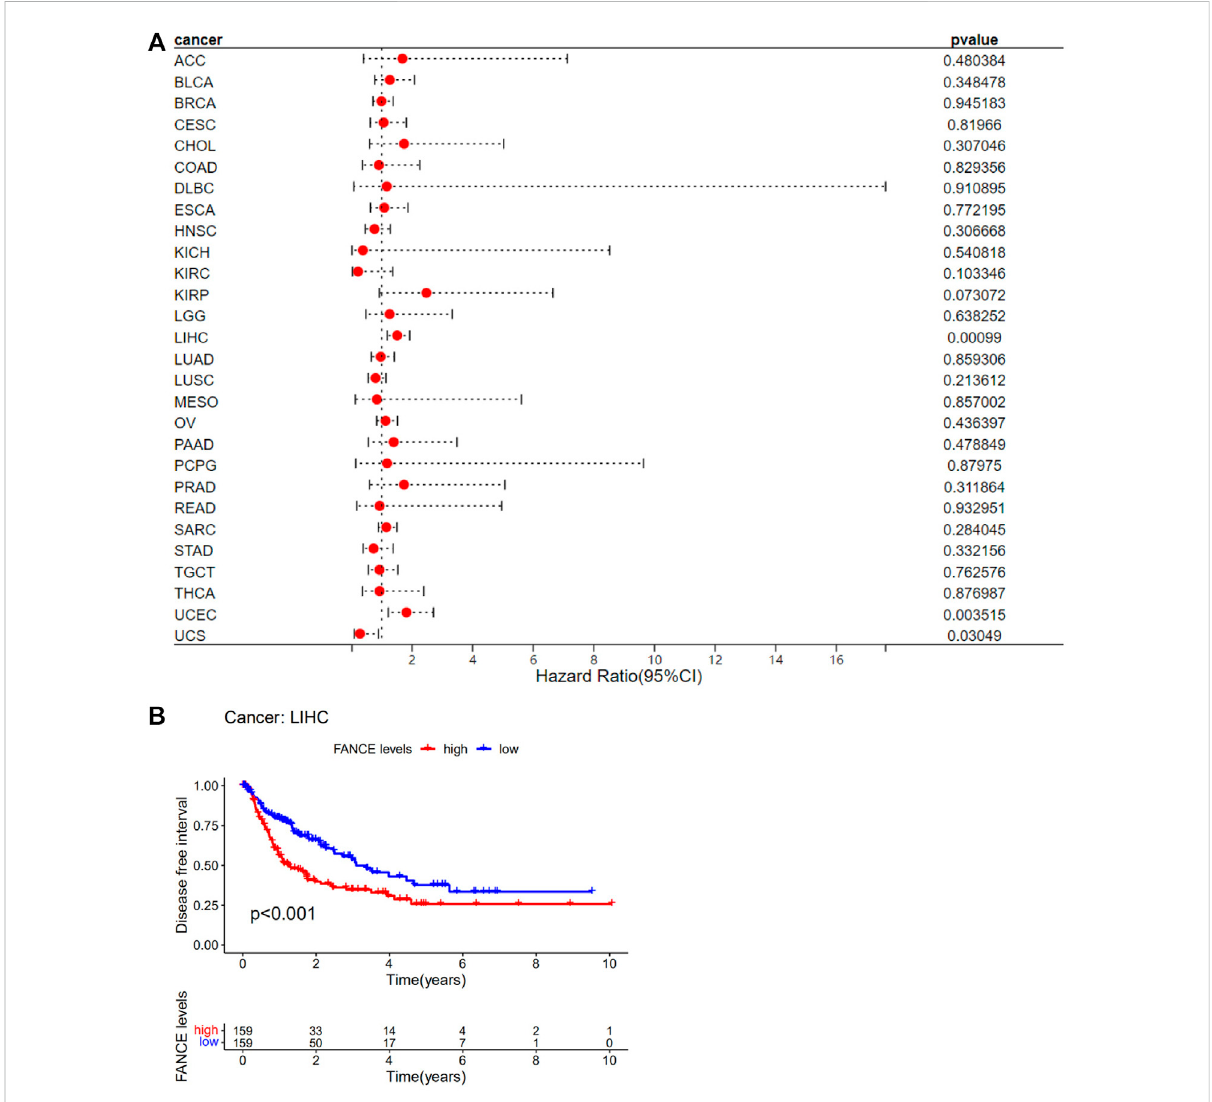
FIGURE 7 Correlation between FANCE expression and disease-freeinterval (DFI) usingdata from theTGCAdatabase. (A) Forest plotof FANCE expression and DFI in 32 cancers. (B) The Kaplan – Meier survival analysis for FANCE expression and DFI in LIHC. * p < .05; ** p < .01; and *** p <